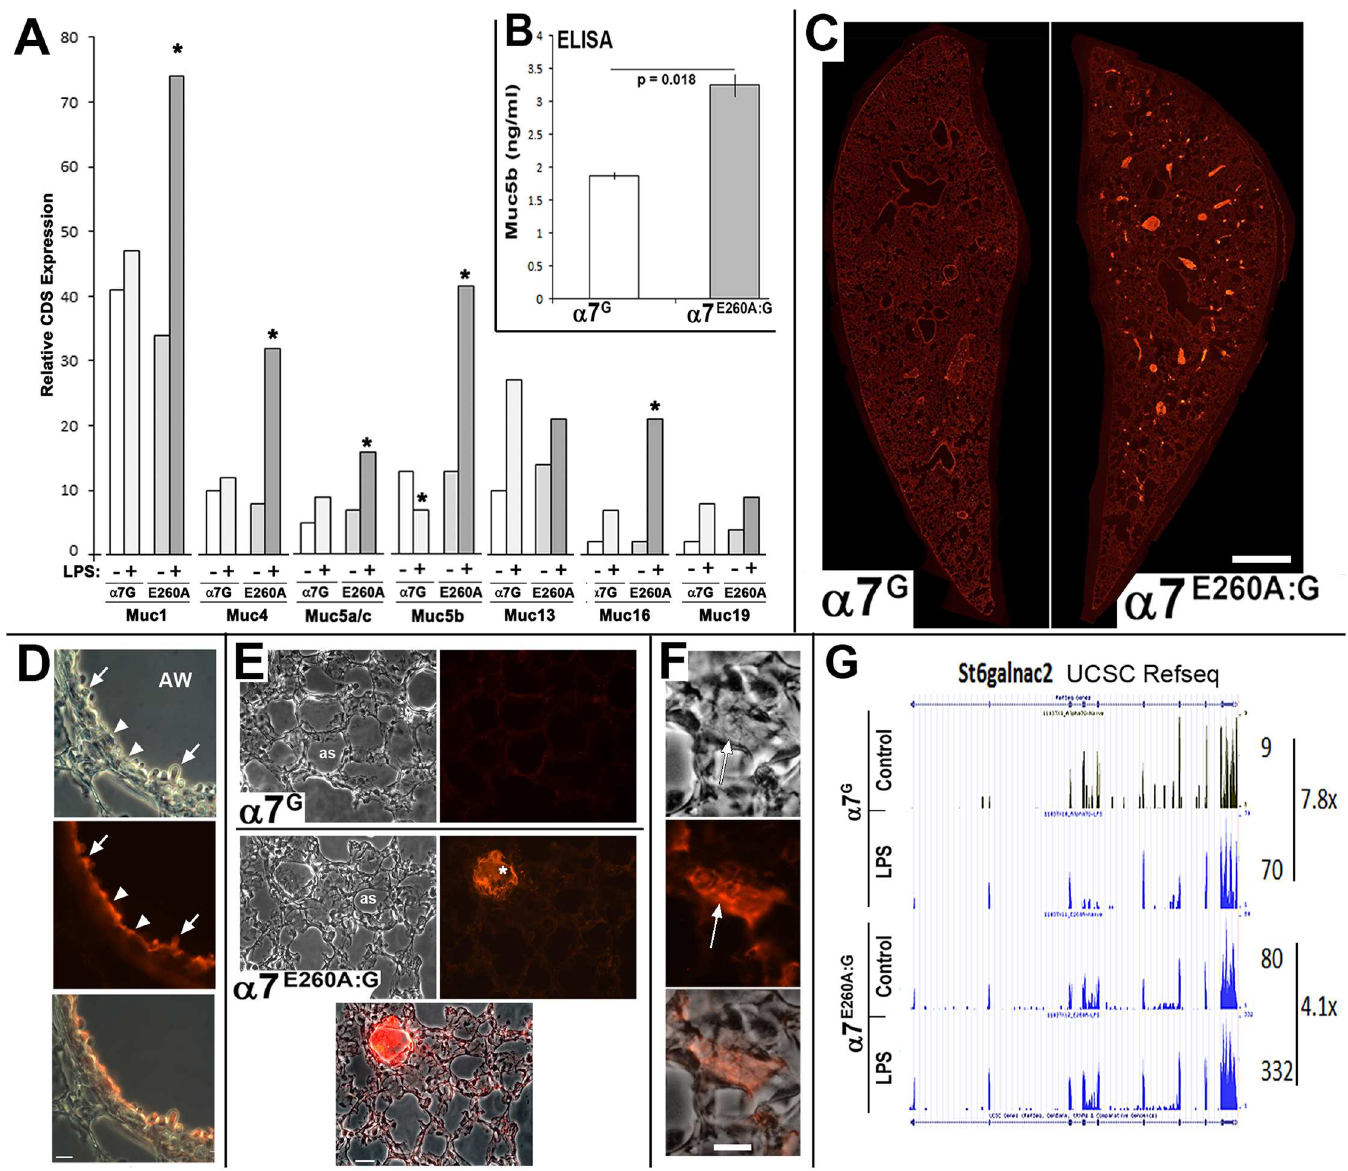
Fig 6. Dysregulation and accumulation of mucins in airways of the α 7 E260A:G lung. A) RNA-Seqresults showingCDS quantitationof read-depthfor the identified mucins in sample of α 7 G or α 7 E260A:G (E260A) genotypes with (+) and without (-) i.n. LPS challenge.Asterisk ( * ) designates a significant(P <